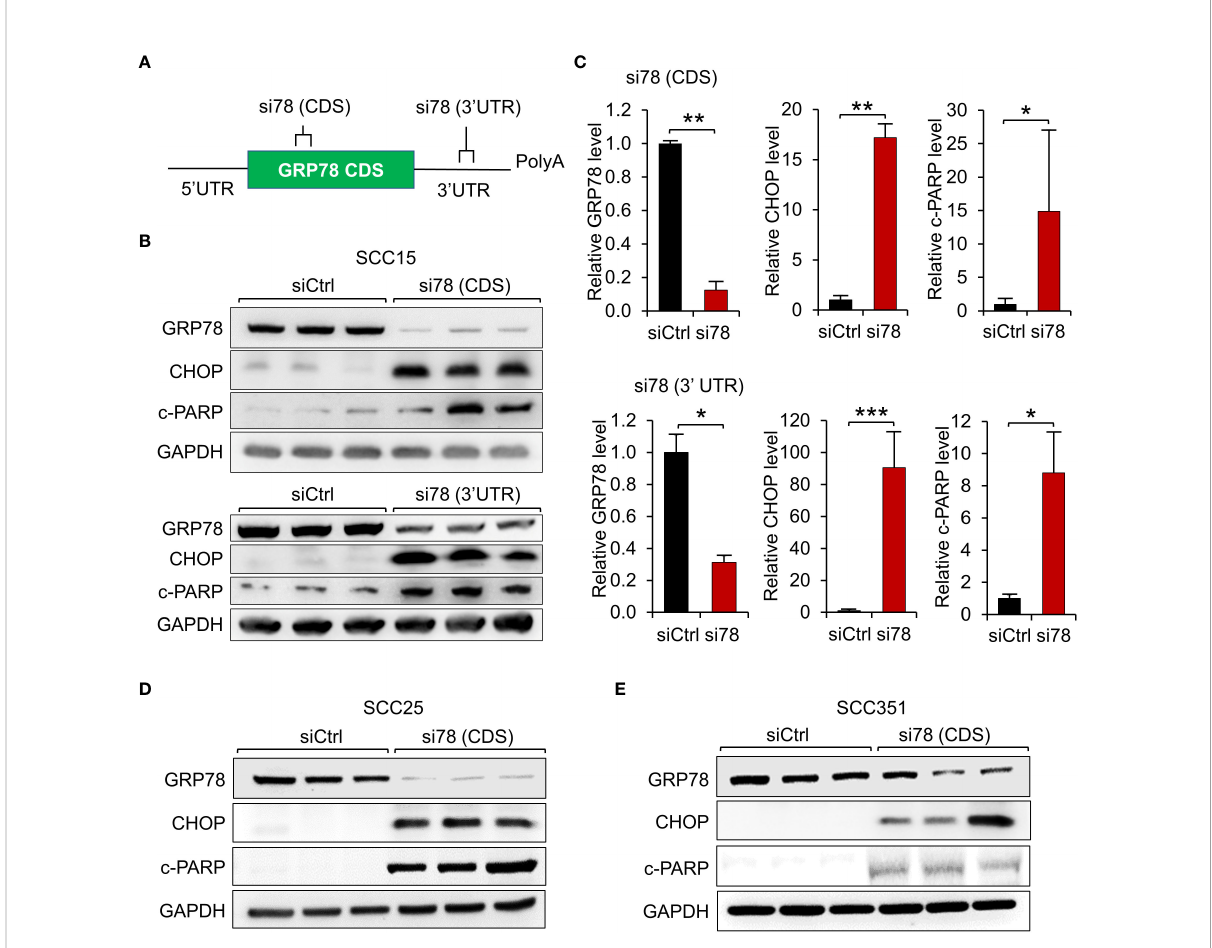
FIGURE 2 GRP78 knockdown induces apoptosis in HNSCC cell lines. (A) Schematic drawing of the locations of the siRNAs targeting the coding sequence (CDS) or the 3 ’ untranslated region (UTR) of the GRP78 mRNA. (B) Western blot analysis of lysates from SCC15 cells transfected with si78 (CDS), si78 (3 ’ UTR) or control siRNA (siCtrl) with a scrambled RNA sequence. The protein levels of GRP78, CHOP and cleaved-PARP (c-PARP) were determined, with GAPDH serving as loading control. (C) Quantitation of the relative levels of GRP78, CHOP and c-PARP after normalization with GAPDH serving as loading control. Data are presented as means ± S.D. (n=3). * P ≤ 0.05, ** P ≤ 0.01, *** P ≤ 0.001 (Student ’ s t test). (D) Western blot analysis of lysates from SCC25 cells and (E) from SCC351 cells transfected with si78 (CDS) or control siRNA (siCtrl) for the indicated